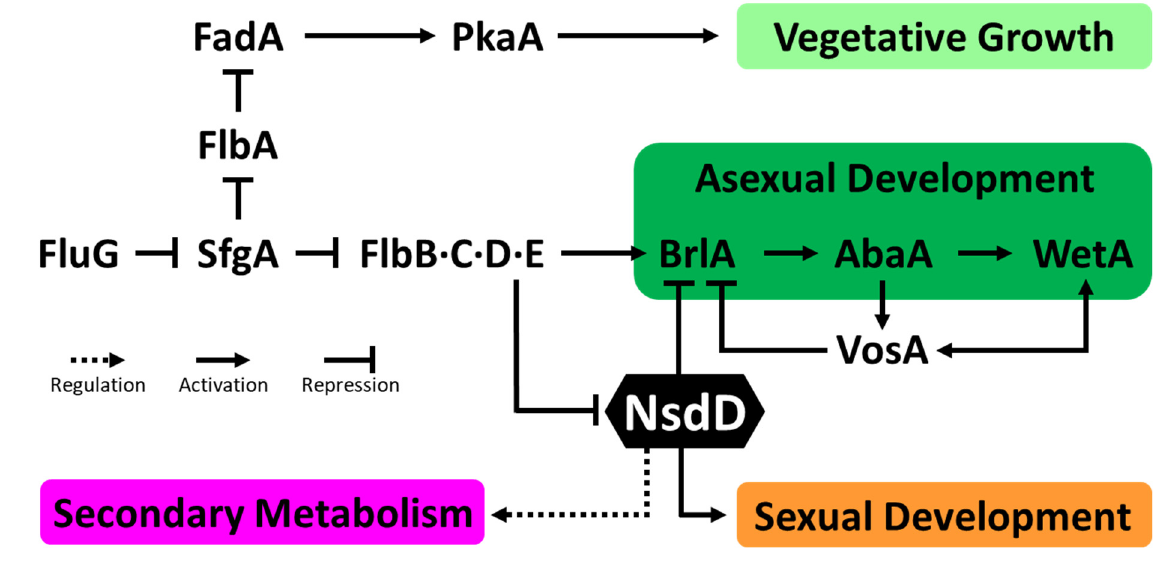
Figure 7. A genetic model for growth, developmental, and metabolic control in Aspergillus . An arrow with a solid line indicates a positive regulation (activation) in a relationship, an arrow with a dotted line indicates an unspecified regulation (can be activating or repressing), and a blunt-ended line indicates a repressive role in the relationship.